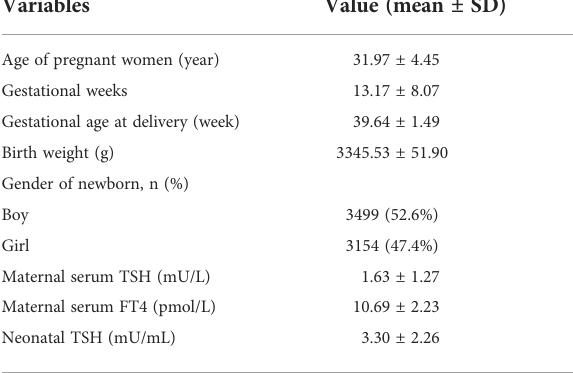
TABLE 1 Baseline characteristics of all subjects and the concentrations of maternal and neonatal TSH and FT4 and